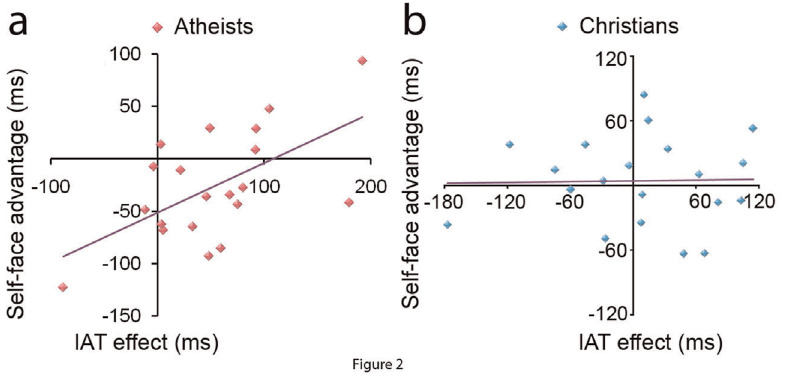
Figure 2. Correlation Result of Atheists and Christians. The X-axis represents the IAT effect (i. e., RTs to self-face when it is associated with negative items minus when associated with positive items). The Y-axis represents self-face advantage (i. e., left hand RTs to self-face minus those to friend-face in the Face-owner identification task).